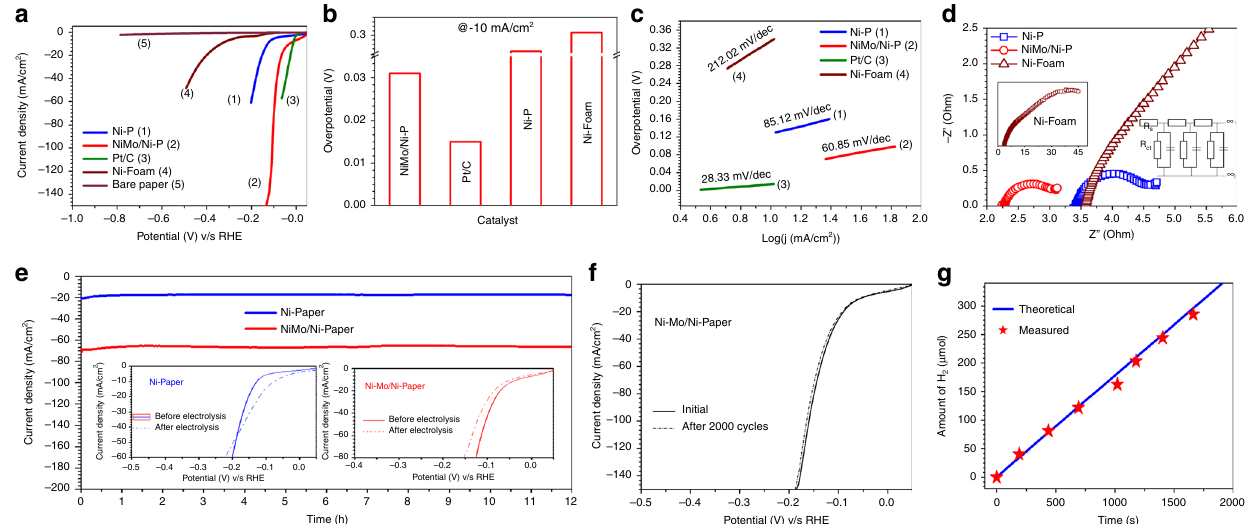
Fig. 6 Electrochemical performance of NiMo/Ni-P electrode towards HER. a HER polarization curves (iR-corrected) with a scan rate of 10 mV s − 1 in 1 M KOH, b the potentials required to reach − 10 mA cm − 2 , c corresponding Tafel plots and d EIS spectra under a dc bias of − 0.1 V for all catalysts. Insets show the Nyquist plot of Ni-foam and equivalent transmission line model circuit. e Chronoamperometric stability test of NiMo/Ni-P and Ni-P for 12 h at − 0.15 V (without iR-correction). Insets show steady state LSV plots before and after 12 h. f LSV scan of NiMo/Ni-P electrode before and after 2000 CV cycles showing no apparent changes in the HER activity. g Faradic ef fi ciency measurement of NiMo/Ni-P showing the theoretically calculated and experimentally measured H 2 gas with